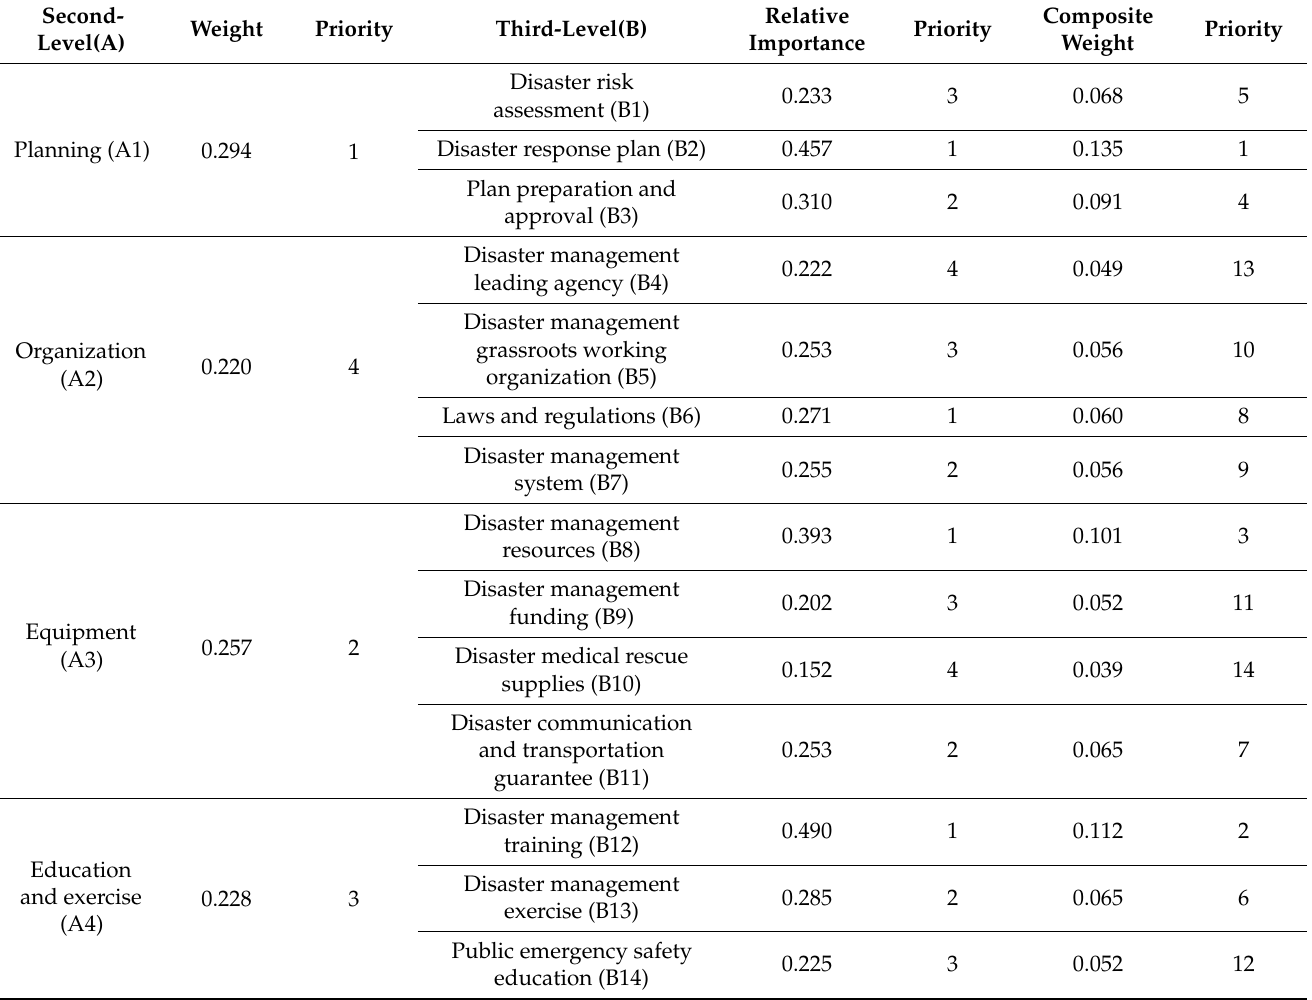
Table 3. Weight of each index of the disaster preparedness capability evaluation index